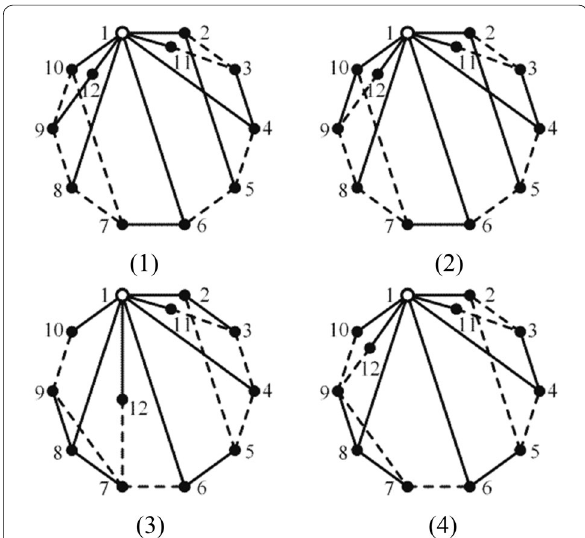
Figure 6 Four DBGs selected from link assortments [2; 9; 0; 0; 0; 1] and [3; 7; 1; 0; 0; 1]